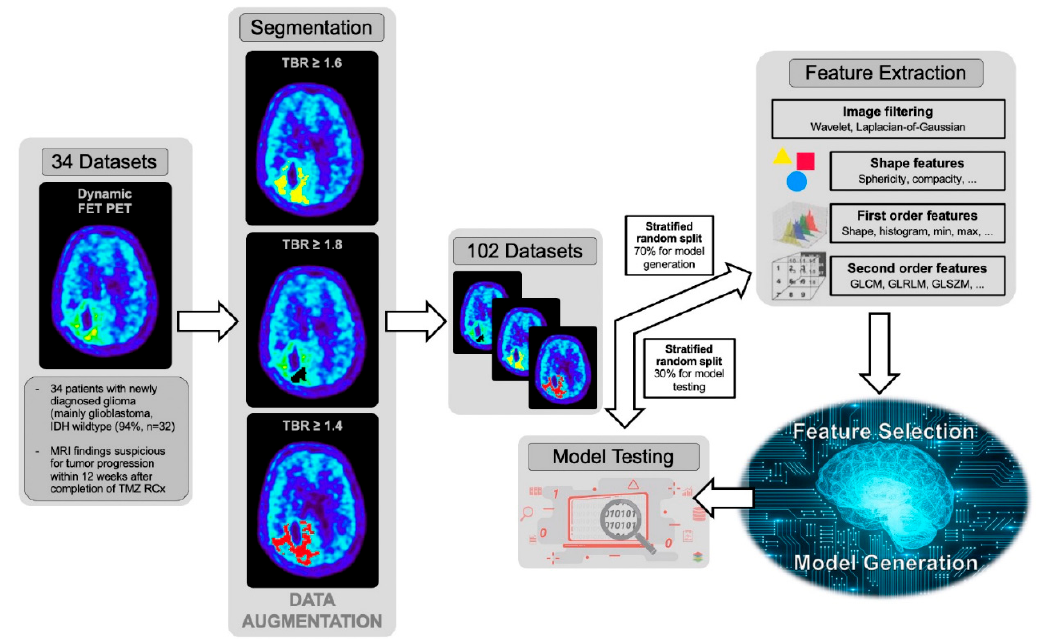
Figure 1. Radiomics workflow—Dynamic O-(2-[ 18 F]fluoroethyl)-L-tyrosine (FET) positron emission tomography (PET) measurements of 34 patients with newly diagnosed glioma (mainly